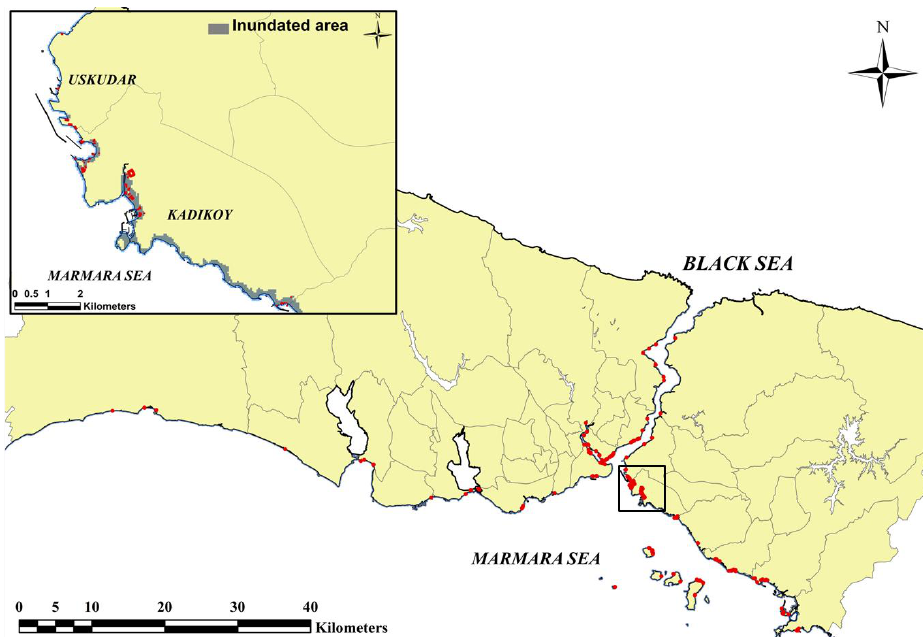
Figure 9. Spatial distribution of the public buildings at risk: Buildings highlighted by red. Embedded frame: A closer view of the inundated areas 2 Fig. 9. Spatial distribution of the public buildings at risk: buildings highlighted in red. Embedded frame: a closer view of the inundated where most of the public buildings are located. 3 areas where most of the public buildings are